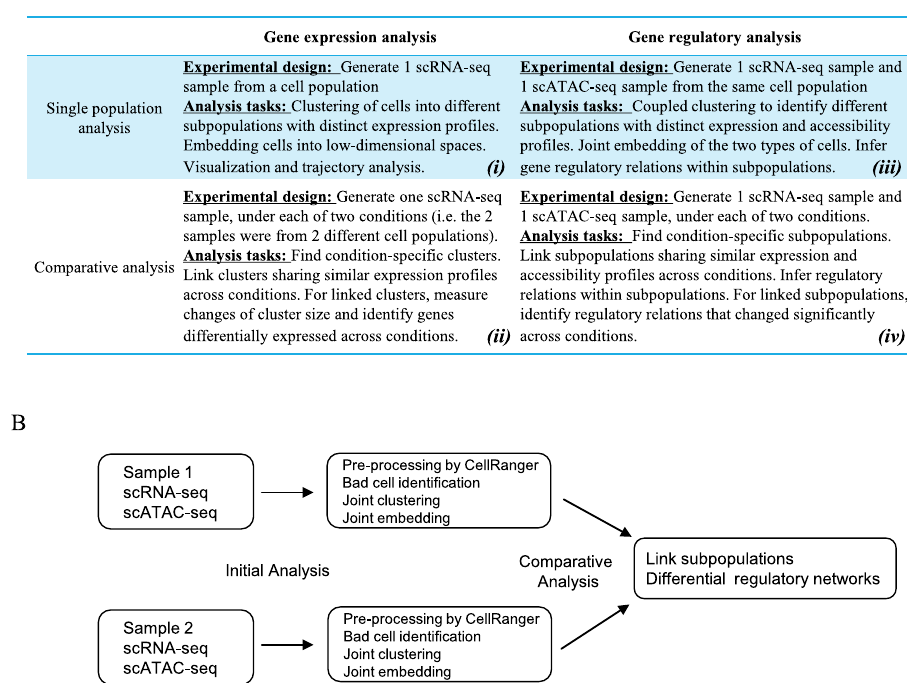
Fig. 1 Schematic overview of comparative regulatory analysis. A Summary of four types of single-cell genomic analysis. Left column: expression analysis by sc-RNA-seq. Right column: regulatory analysis based on paired scRNA-seq and scATAC-seq. Top row: analysis under one condition. Bottom row: comparative analysis. B Comparative regulatory analysis pipeline for scATAC-seq and scRNA-seq data from two